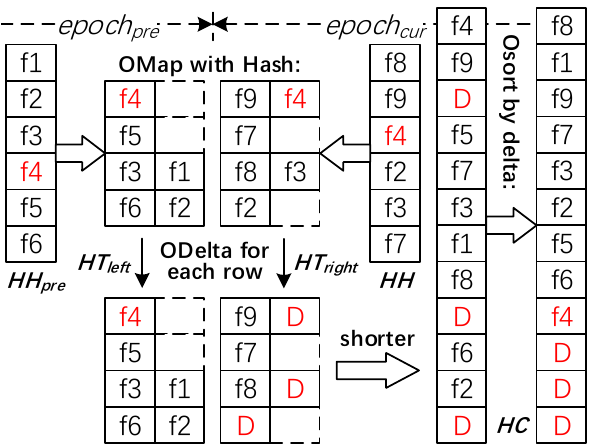
Figure 7. Oblivious heavy-change candidates